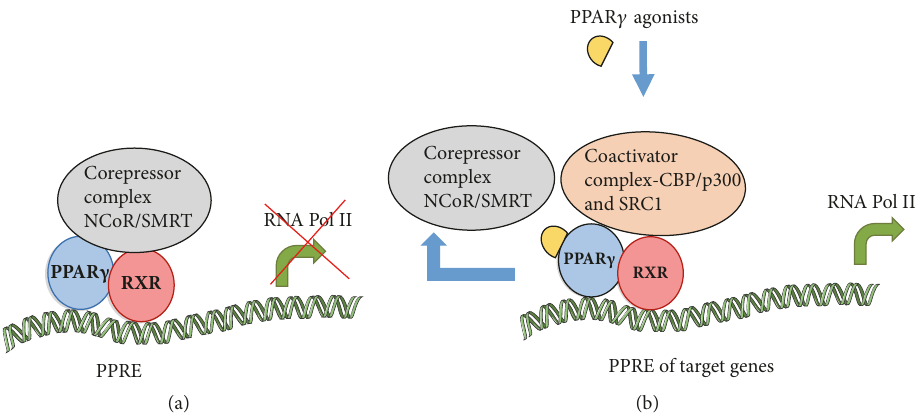
Figure 1: Mechanismof actionof PPAR 𝛾 agonists.(a) During unstimulatedconditions, the heterodimeris associatedwith corepressorswhich suppress gene transcription. (b) Binding of PPAR 𝛾 agonist induces release of corepressor complex, while binding to coactivator complex, thereby stimulating the response elements of target genes. This scaffold recruits histone acetyl transferase and RNA polymerase leading to transcription of target genes.